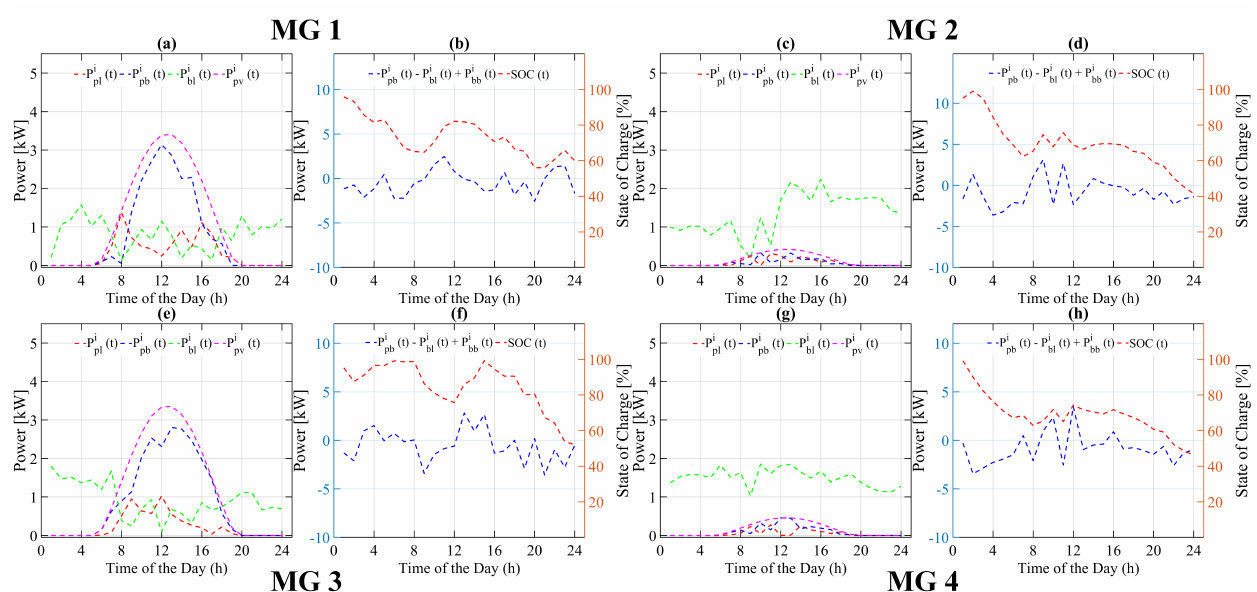
Figure 11. Power flow of various system variables of each microgrid using proposed optimiza- tion based energy management strategy for case C. ( a , c , e , g ) Power flow of PV, battery and Load, ( b , d , f , h ) Battery charging/discharging and state of